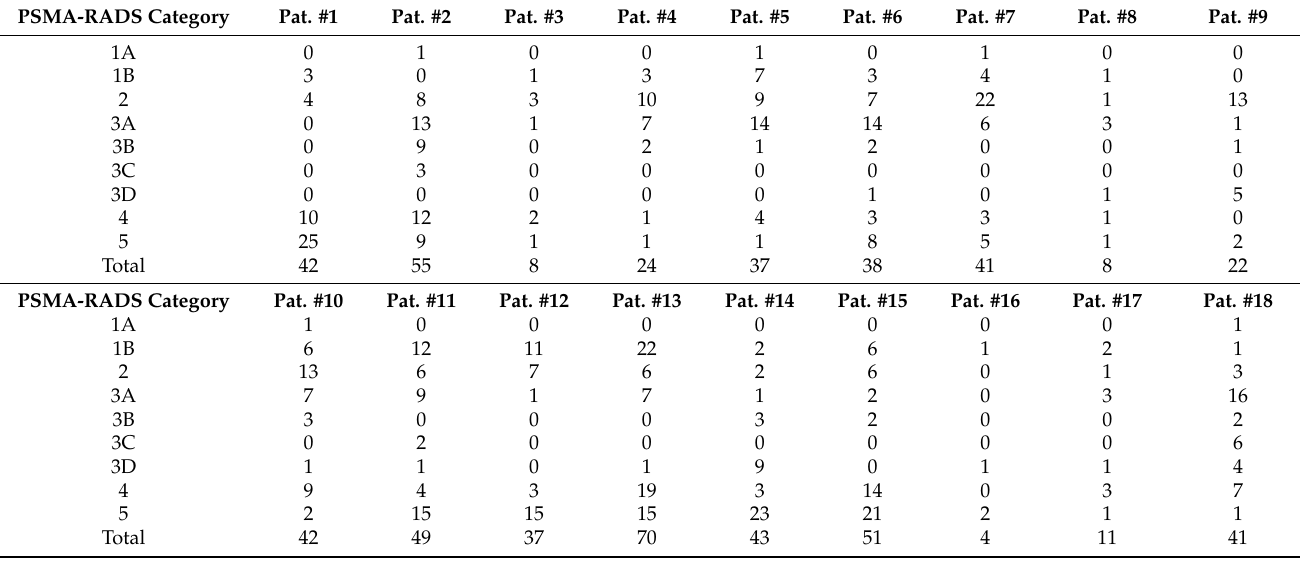
Table A2. Descriptive statistics of number of lesions per PSMA-RADS category and total lesions for each of the 18